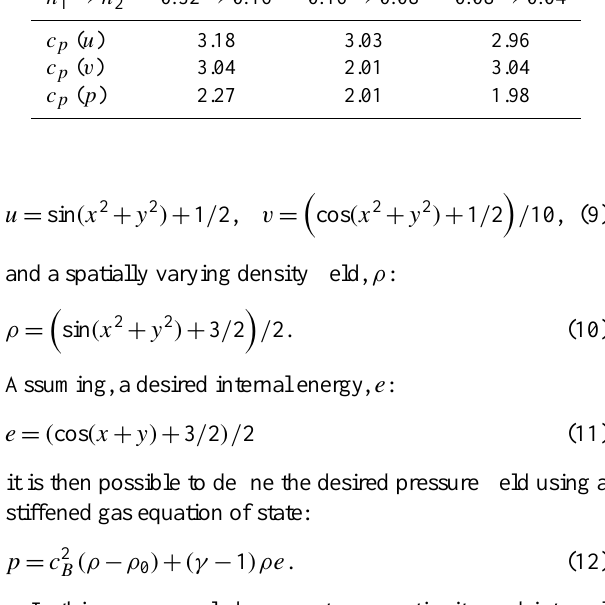
Table 3. Spatial order of convergence results for the method of manufactured solutions compressible Navier-Stokes test case de- scribed in Sect. 4.1.2. The difference between the analytical and numerical solutions using a piecewise-quadratic velocity, (u,v) , a piecewise-linear pressure, p , a piecewise-quadratic density, ρ , and a piecewise-linear internal energy, e , Galerkin discretisation are cal- culated in the L 2 norm. The ratio between these on two spatial mesh resolutions, h 1 and h 2 , are used to estimate the order of spa- tial convergence of the model for this problem. The expected order of convergence is observed for all variables. h 1 → h